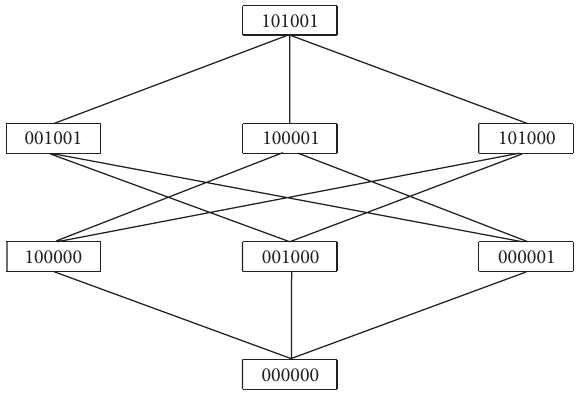
Figure 2: Γ[𝑢 𝑛,𝑘,𝑧 ] , 𝑢 𝑛,𝑘,𝑧 = 101001 .